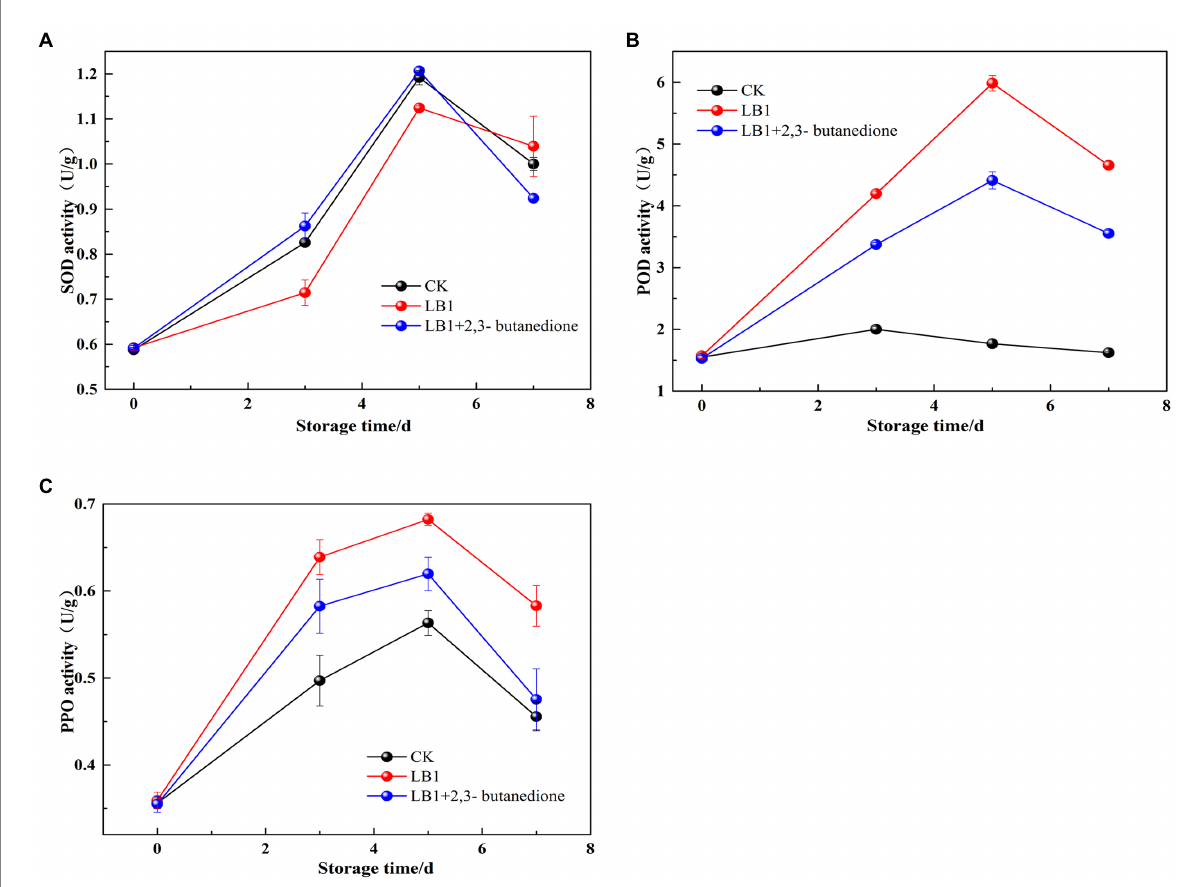
FIGURE 7 Determination of Peroxidase (POD), polyphenoloxidase enzymes (PPO) and superoxide dismutase (SOD) of postharvest wolfberry fruits ( A : SOD, B : POD, C :